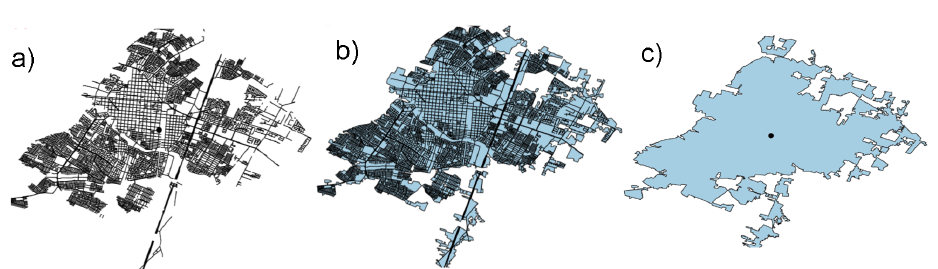
Figure 3. A typical sequence of image processing used to obtain the structure and shape of street networks, in this case Chillán city (#10, Table 1). ( a ) The street network directly extracted from public data [50]. ( b ) A delineation of the network by adopting criteria proposed in [52] and ( c ) delimitation of the masking